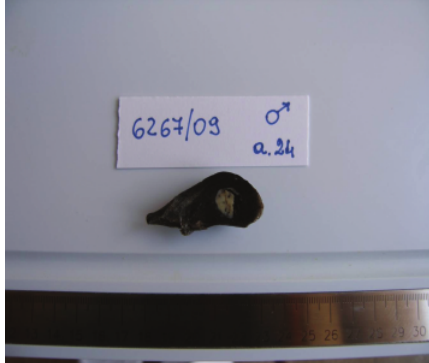
Figure 1: The resected specimen showed a small and well-defined solid